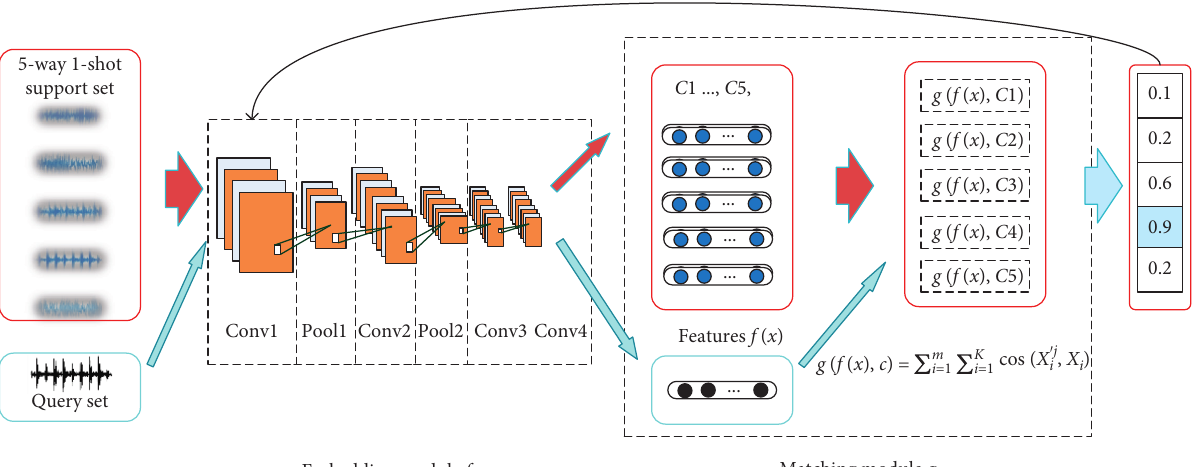
Figure 3: The structure of the proposed